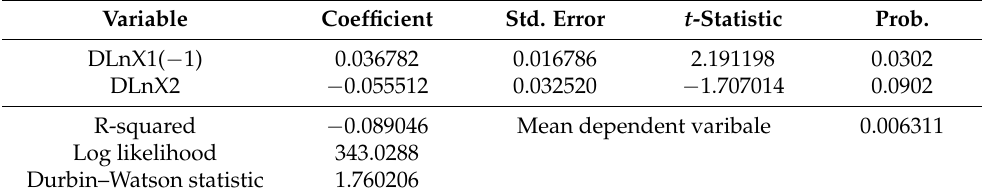
Table 5. Model with no constant. Dependent variable: DLnY. Method: least squares. Sample: